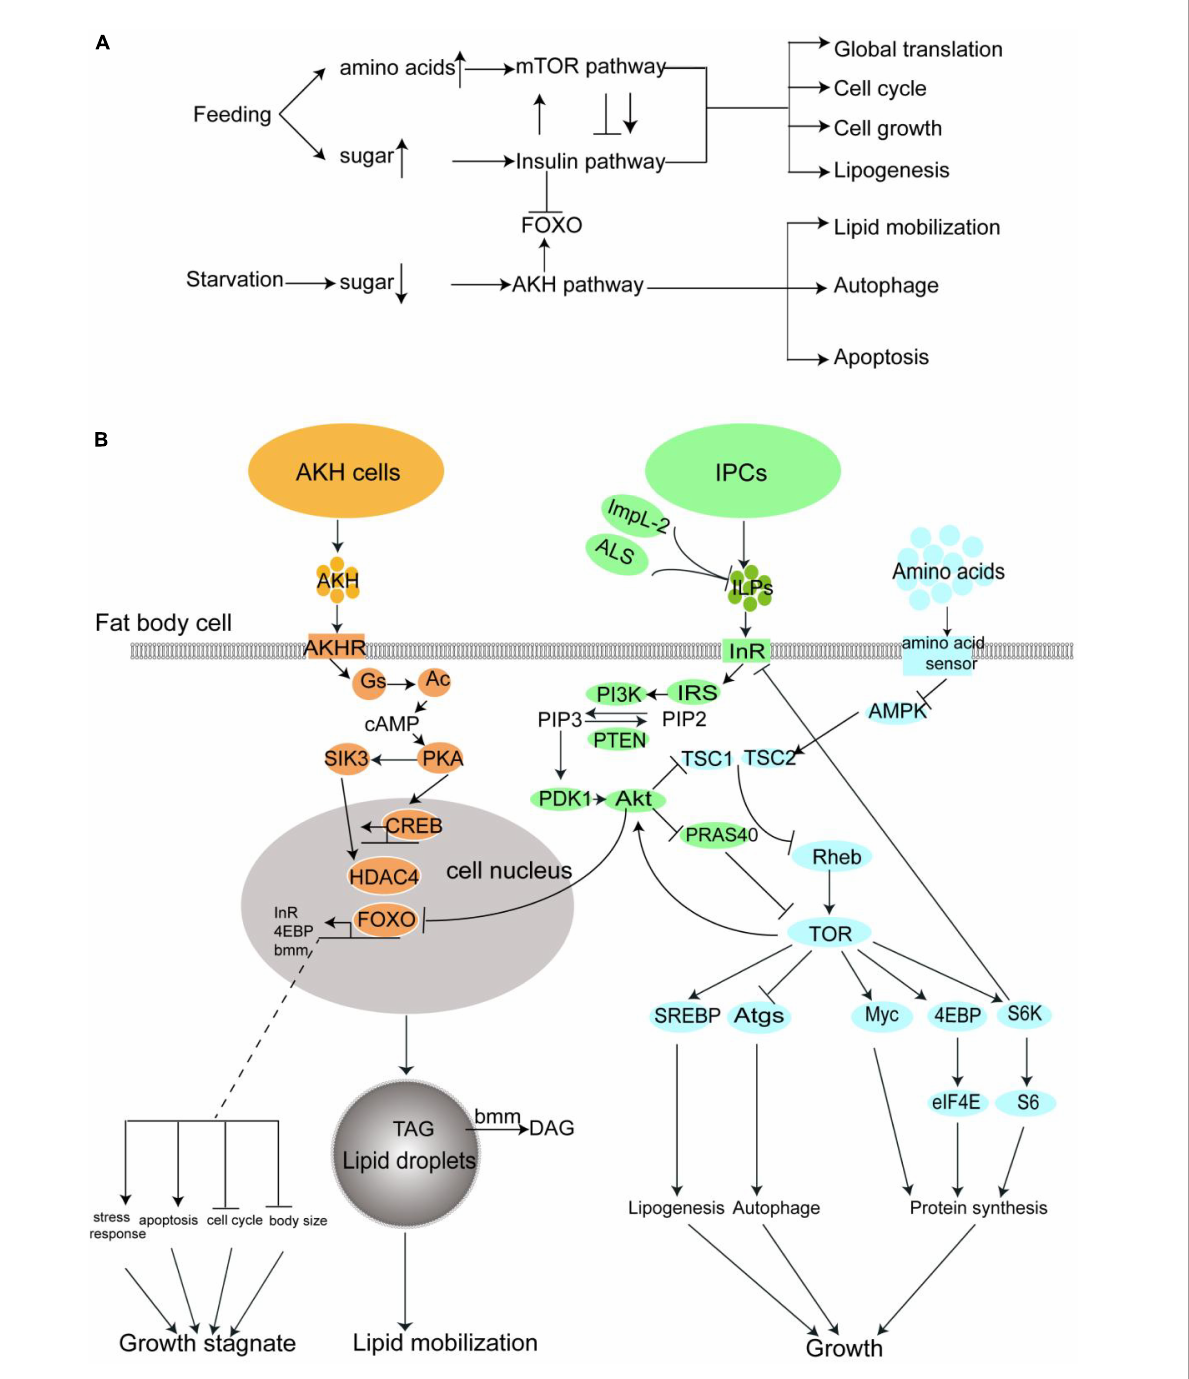
FIGURE1 The nutrient metabolism of fruit fly are regulated major by three pathway: The insulin pathway, the mTOR pathway, and the AKH pathway. (A) A summary of the interaction and effect of these three pathways. (B) A more detailed diagrammatic sketch of these three pathways.